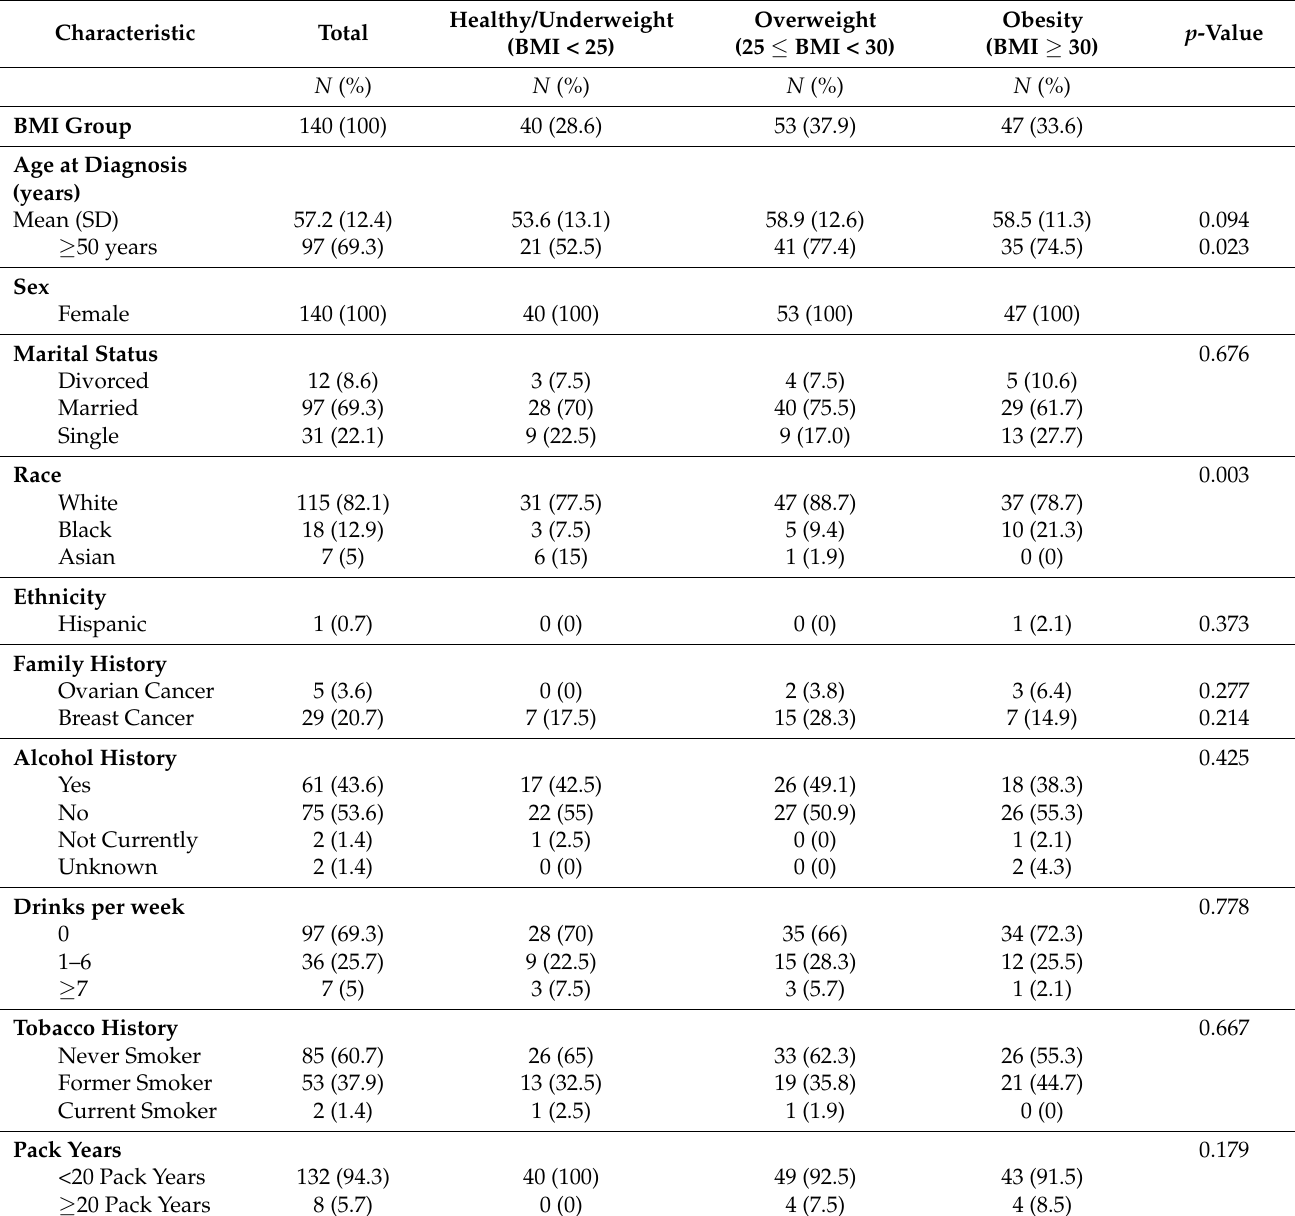
Table 1. Characteristics of included women at diagnosis ( n = 140) from the Breast Cancer Program Longitudinal Repository (BCPLR) at Johns Hopkins